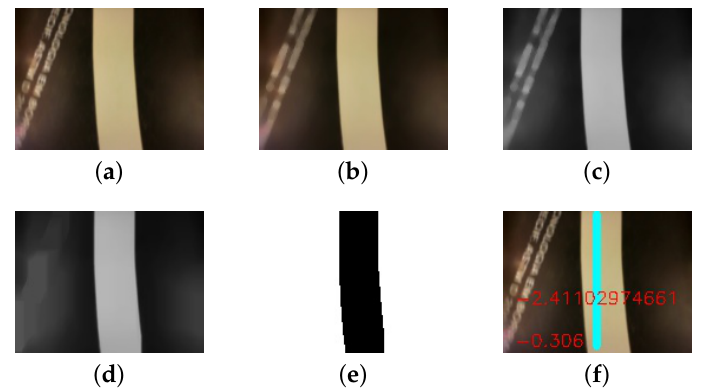
Figure 13. The algorithm resultant images: ( a ) original image; ( b ) after a smoothing filter; ( c ) converted to gray-scale; ( d ) after the opening morphological operation; ( e ) binarized image; ( f ) the original image along a center line, in light blue, and angle and distance errors,